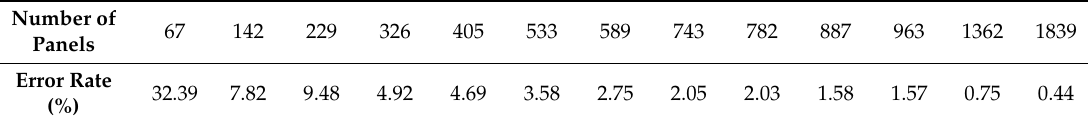
Table 2. The simulation error rate for the different panel quantities relative to the panel size of 4987 for the power obtained from the converter.